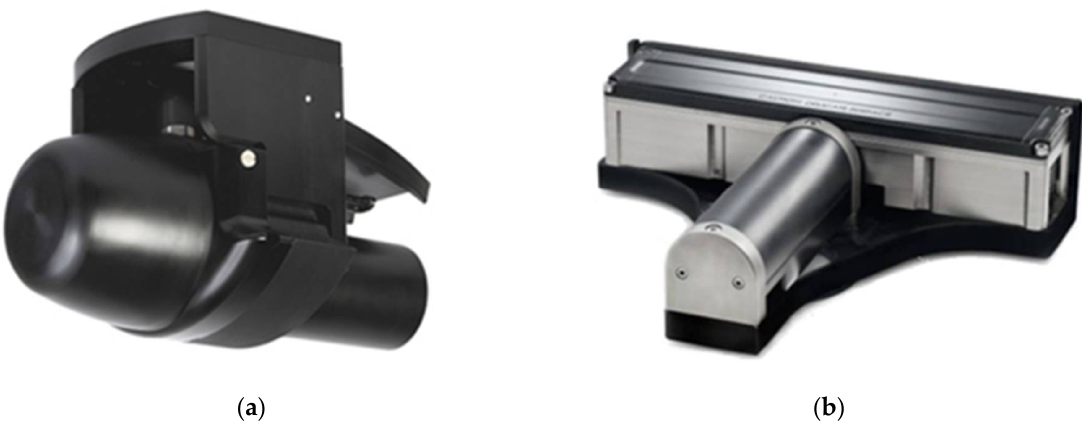
Figure 1. ( a ) NORBIT-iWBMS, and ( b ) Teledyne Reson SeaBat T50P.